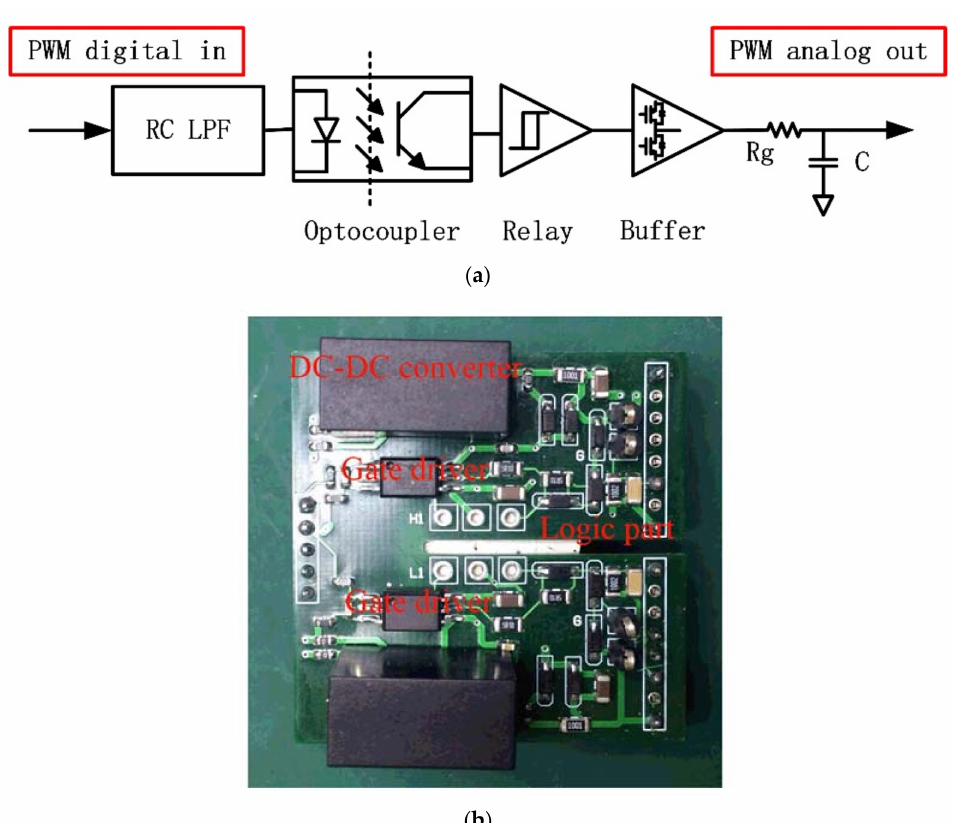
Figure 10. ( a ) The schematic of gate driver; ( b ) The switch gate